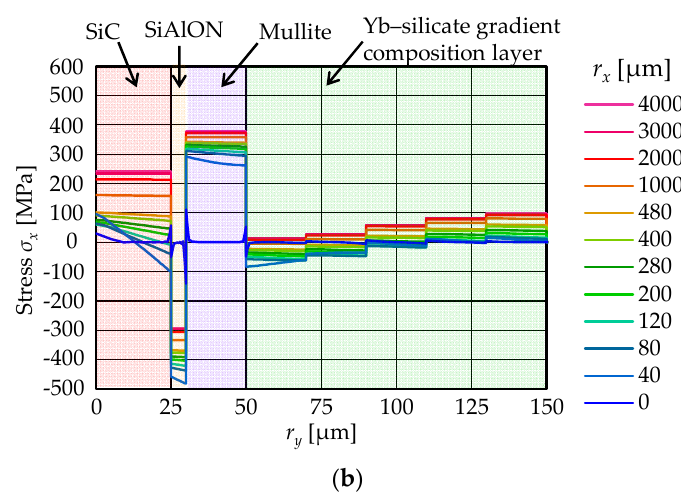
Figure 8. ( a ) σ y distributions, and ( b ) σ x distributions in coating layers along the y axis at the positions r x distant from right SiC/substrate interface edge in the x direction.